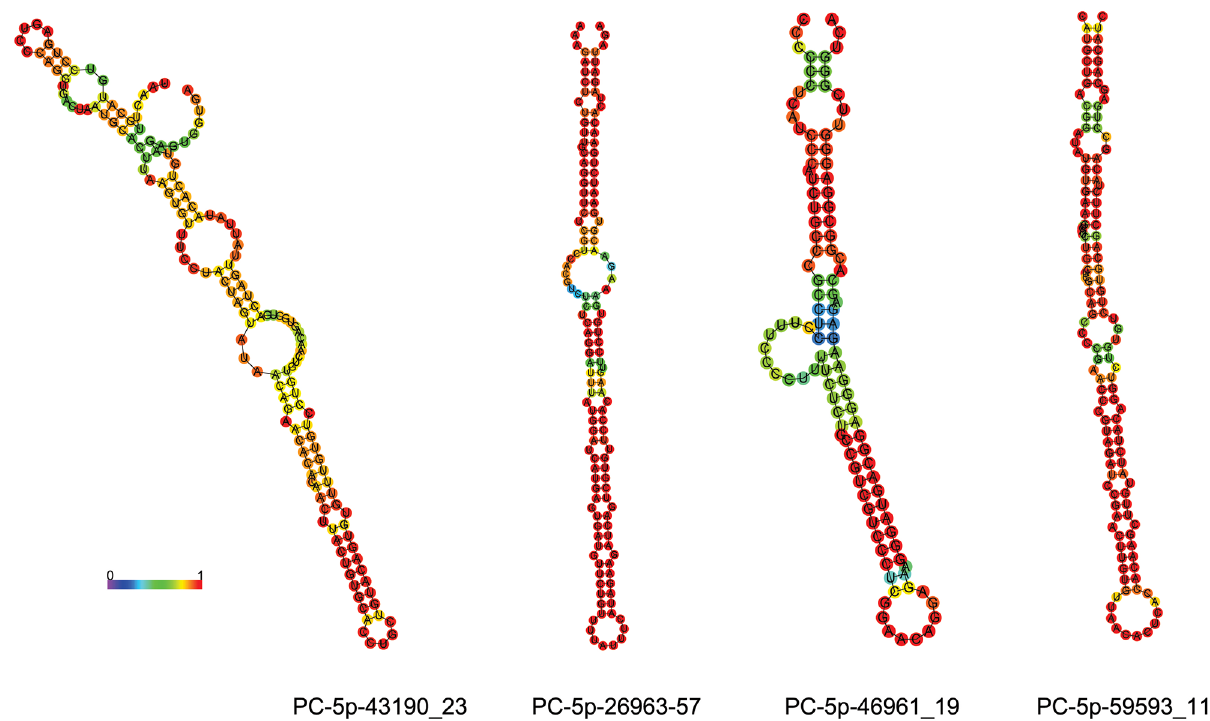
Fig 6. The illustration of four novel miRNAs in P . olivaceus . The secondary structures formed by four novel miRNA precursors are illustratedby RNAfold. The colour bar represents base-pairprobabilities from 0 (blue) to 1 (red).